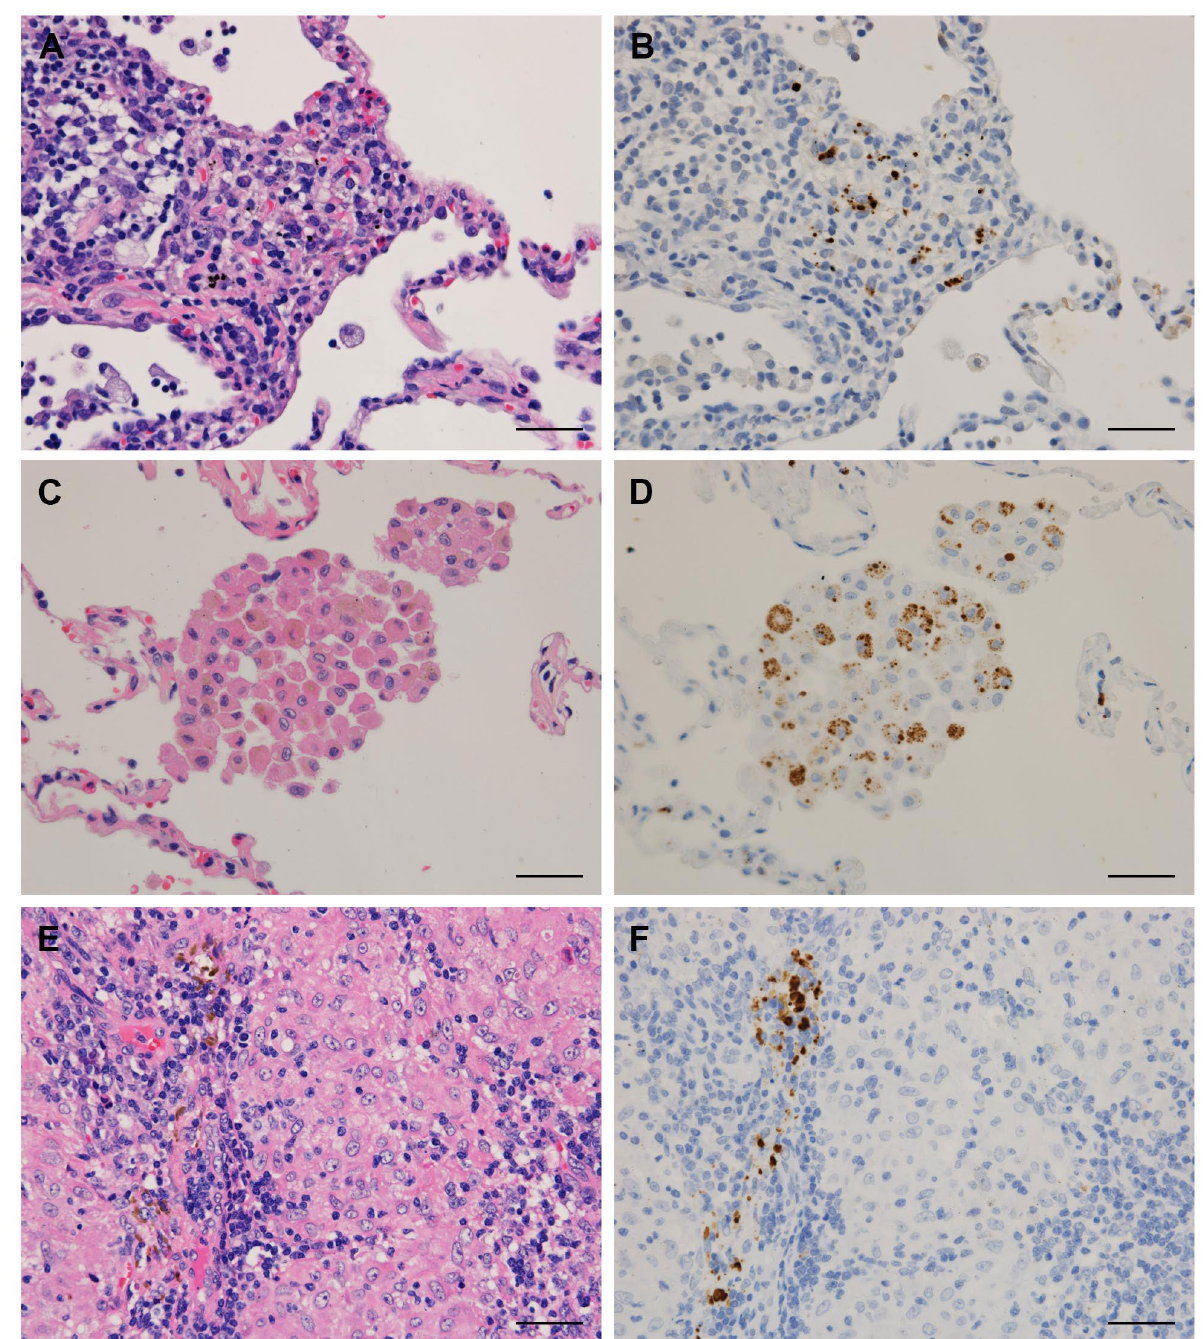
Figure 2. P. acnes detected in other areas outside granulomas such as lung interstitial or alveolar macrophages and lymph node sinus macrophages. Hematoxylin–eosin staining and immunohistochemistry with P. acnes -specific monoclonal antibody (PAB) are shown pairwise. PAB-reactive P. acnes are observed in a cluster of interstitial macrophages with inflammation found in a TBLB sample of hypersensitivity pneumonia ( A , B ), and in a ball-like cluster of eosinophilic alveolar macrophages found in a VATS sample of granulomatosis with polyangiitis ( C , D ), both of which were histologically differentiated from granulomas. In the lymph nodes with sarcoid reaction ( E , F ), PAB-reactive P. acnes including large ovoid Hamazaki–Wesenberg bodies are observed in the narrowed lymphatic sinus between granulomas with no P. acnes detected inside. Scale bar: 50 μm.